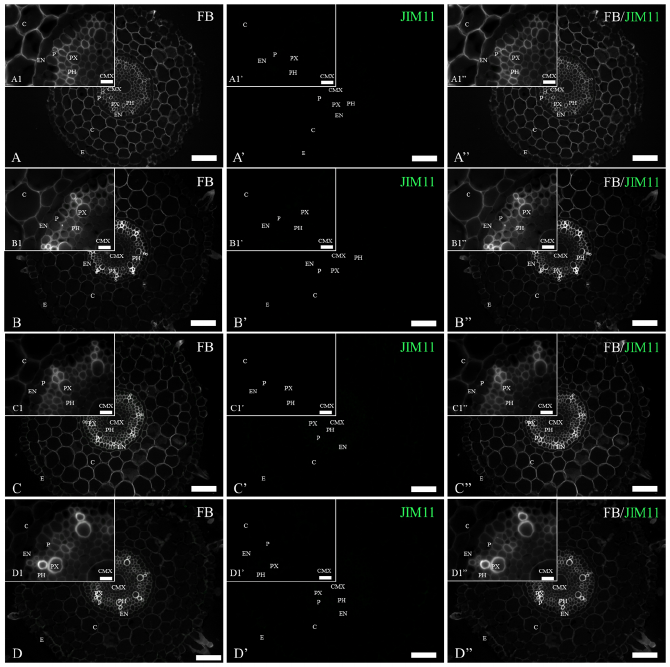
Figure A2. Immunolocalization of the JIM11 epitope ( A – D ) in cross-sections of the B. distachyon roots, ( A , A’ , A” ): the control; ( B , B’ , B” ): 250 µM 3,4-DHP; ( C , C’ , C” ): 500 µM 3,4-DHP, ( D , D’ , D” ): 750 µM 3,4-DHP. Abbreviations: C—cortex, CMX—central metaxylem, E—epidermis, EN—endo- dermis, FB—fluorescent brightener, P—pericycle, PH—phloem, and PX—protoxylem. The green color shows epitope occurrence. Scale bars: 10 µm for A1–C1, while for the remaining photomicro- graphs, 50 µm.